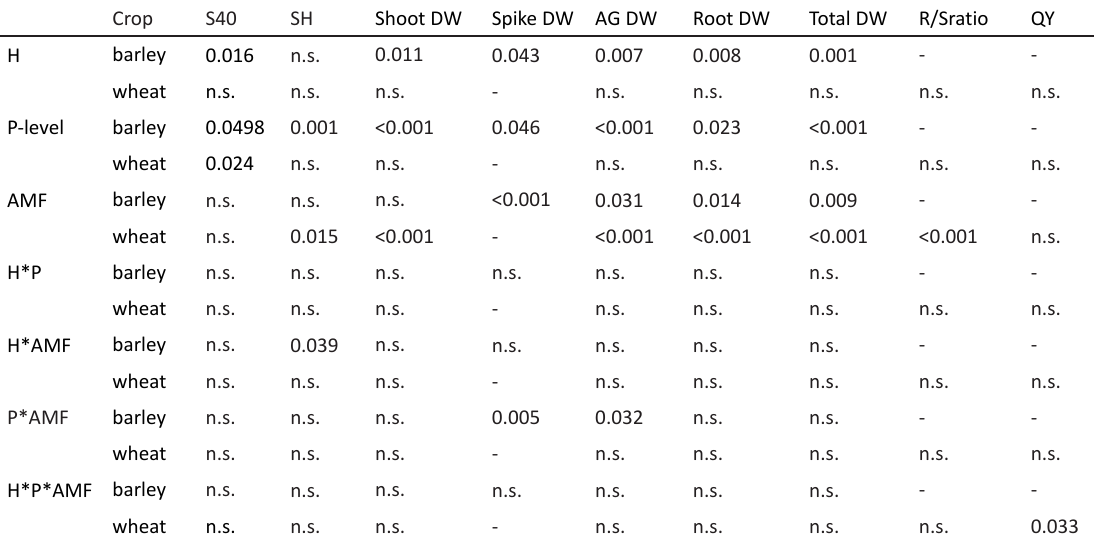
Table 4. Effects of hydrolysate treatment (H), P-level and AMF inoculation on growth parameters of spring barley and winter wheat in the pot experiment: p -values. Plants were harvested at BBCH 49 (50–57) after 55 d